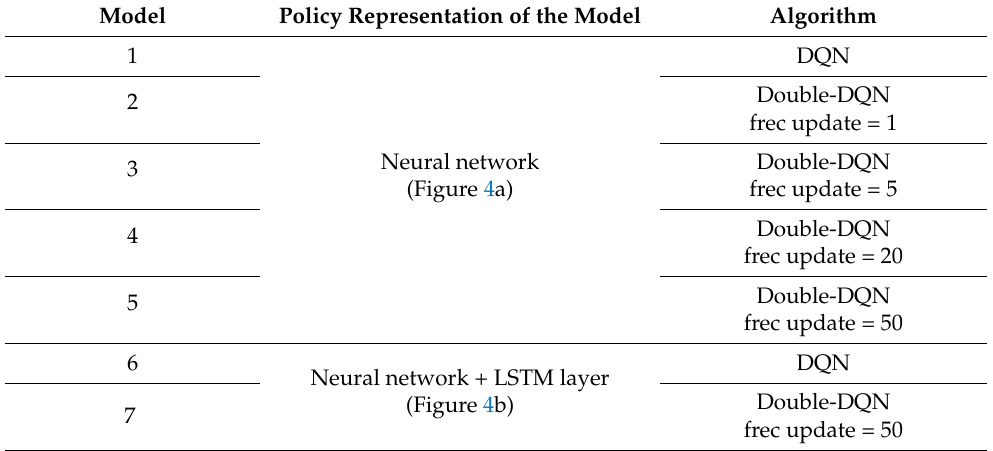
Table 1. Proposed models for